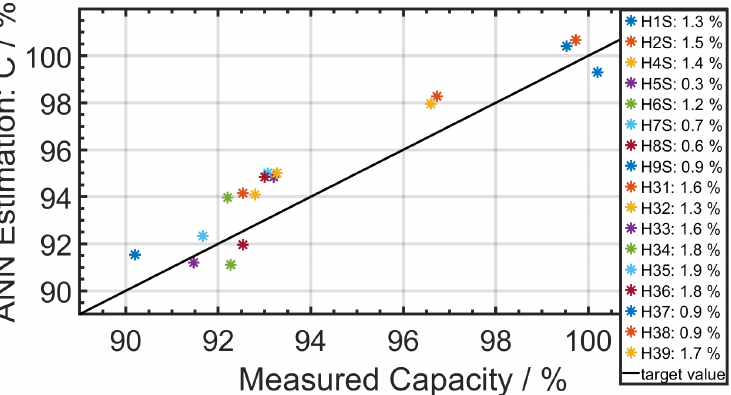
Figure 12. SoHC estimates for Samsung INR18650-15L1 cells by a neural network using EIS data as input are presented. Here the SoHC is defined as the actual capacity related to the nominal capacity. The estimated SoHC is plotted over the measured SoHC. The black line is a guide to the eye of the target values. The overall RMSE was less than 2%. The legend shows the RMSE for each